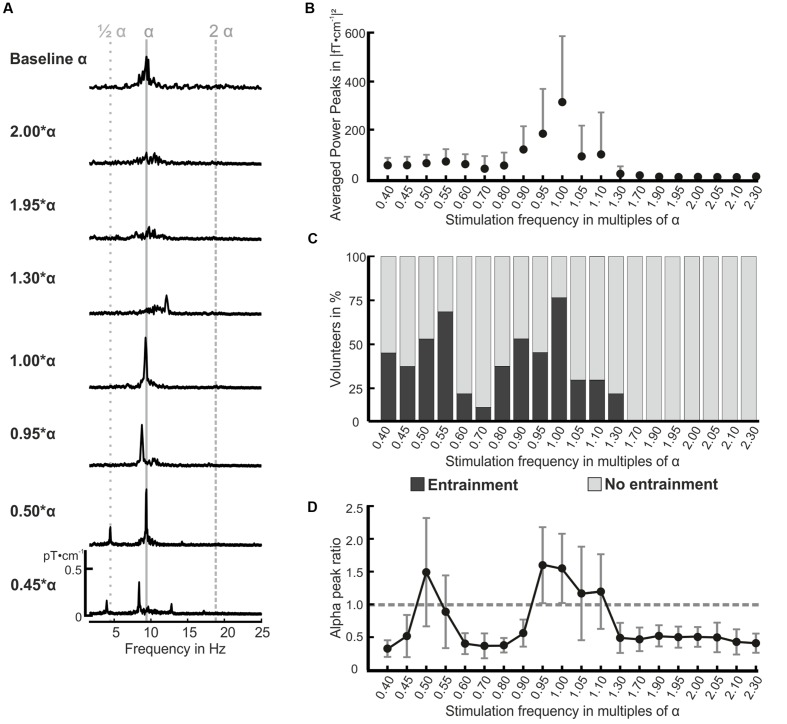
Amplitude spectra for seven stimulation frequencies and resting MEG (resting state α) of volunteer P01 (A), mean power for all volunteers and all stimulation frequencies (B), frequency entrainment classification for all volunteers (C), and the mean alpha peak ratio over all volunteers (D).
(A) The shown amplitude spectra (pT⋅cm-1) were calculated over 24 occipital gradiometer channels and are displayed in the frequency range from 2 to 25 Hz. The estimated individual alpha frequency of the presented volunteer in (A) was 9.6 Hz. Resonance phenomena become obvious for the stimulation frequencies 1.00, 0.95, 0.50, and 0.45∗α. Please see Supplementary Material for amplitude spectra of all volunteers. (B) Presents the mean and positive standard deviation power peaks for all volunteers and stimulation frequencies. (C) The volunteer’s responses in terms of frequency entrainment were classified for each stimulation frequency (x-axis) according to our definition of entrainment and no entrainment in the FFT spectra (concurrence and amplitude threshold). One hundred percent on the ordinate equal 12 volunteers. (D) The alpha peak ratio between the alpha peak of each stimulation frequency and the resting state alpha peak is displayed for all 20 stimulation frequencies (x-axis) as mean and standard deviation for all volunteers. The dotted gray line marks the alpha peak ratio value of 1: all values higher than this indicate an increased alpha activity.